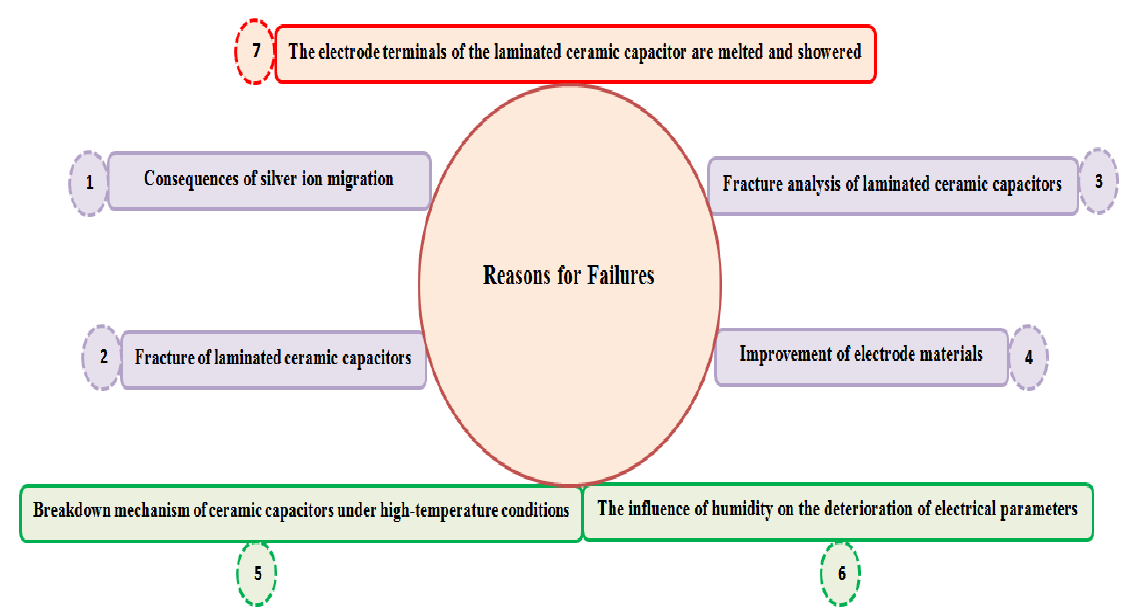
Figure 8. Reasons for the MLCC failure.